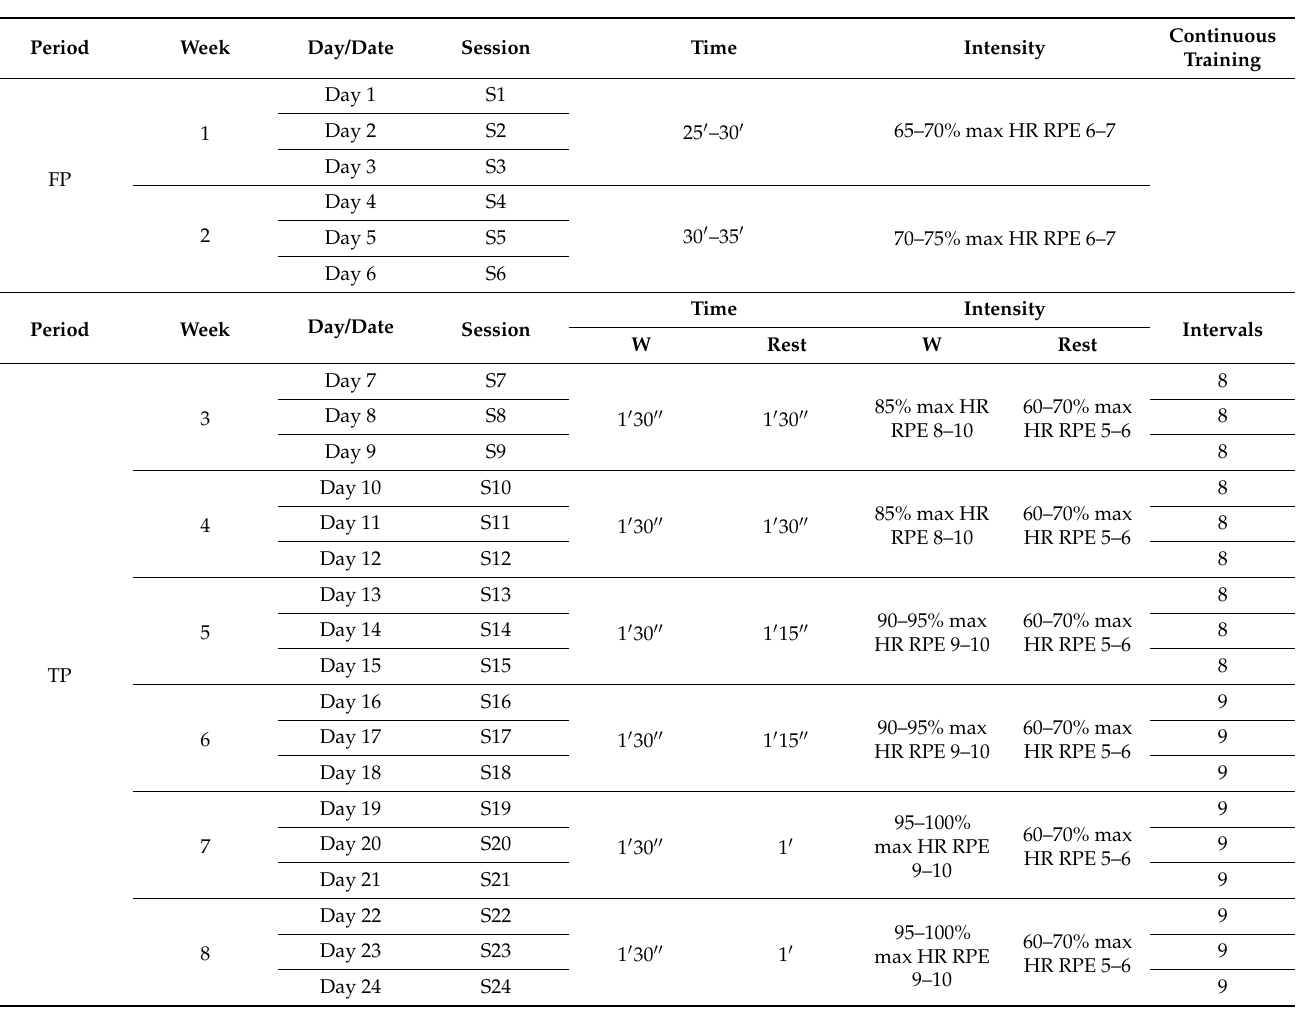
Table 1. Periodization and training distribution for